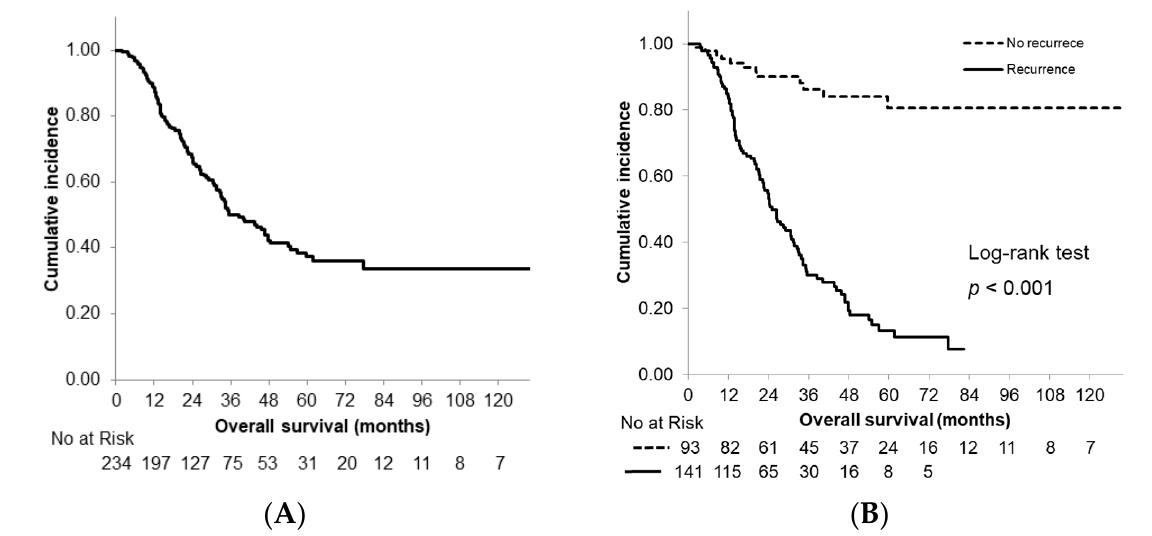
Figure 1. Kaplan–Meier curves of overall survival. ( A ) All patients; ( B ) patients stratified according to recurrence status.